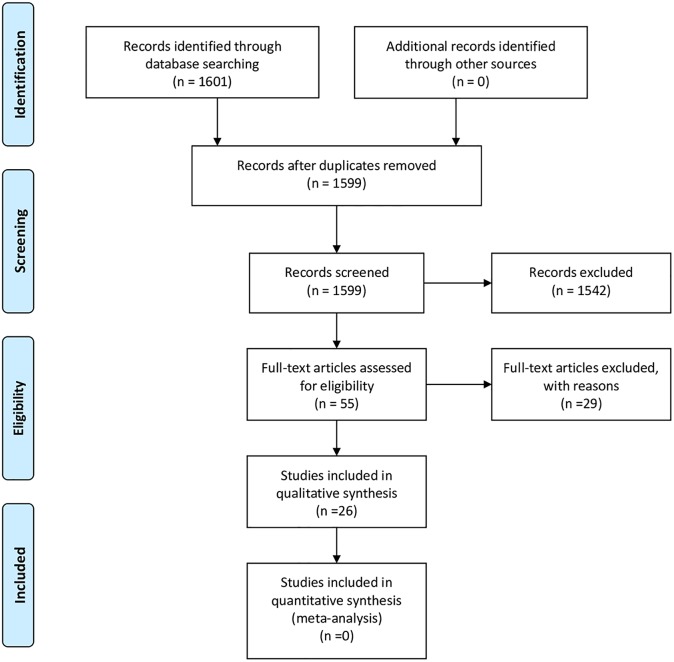
Prisma flowchart.